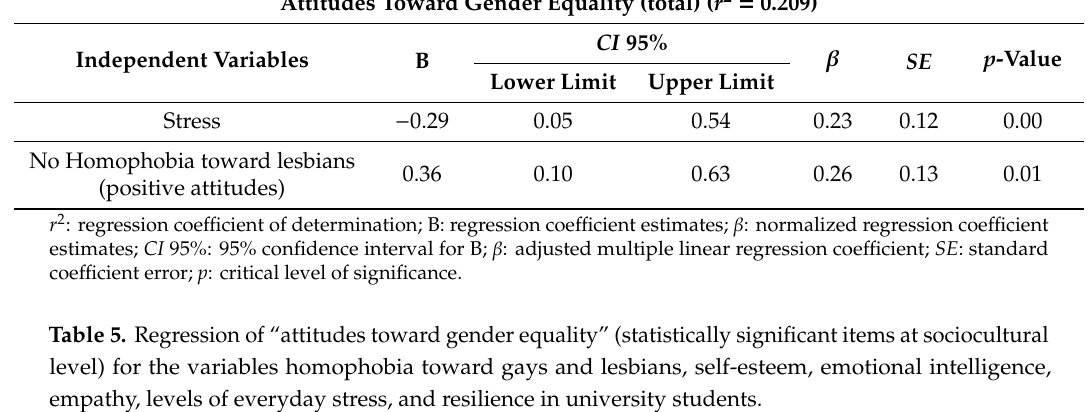
Clothes and Pink Things are More for Girls than for Boys ( r 2 = 0.225) −